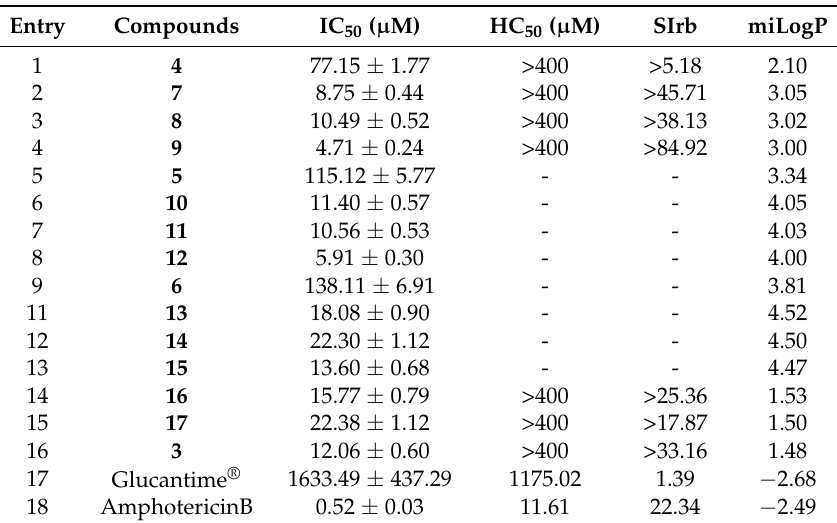
Table 1. The antileishmanial activities against promastigotes of L. amazonensis . Values represent the average IC 50 calculated in three independent experiments ± standard error of the mean. For this calculation, we used the probabilistic regression models with SPSS 13.0 software. SIrb (selectivity index on red blood cell) = HC 50 /IC 50 .